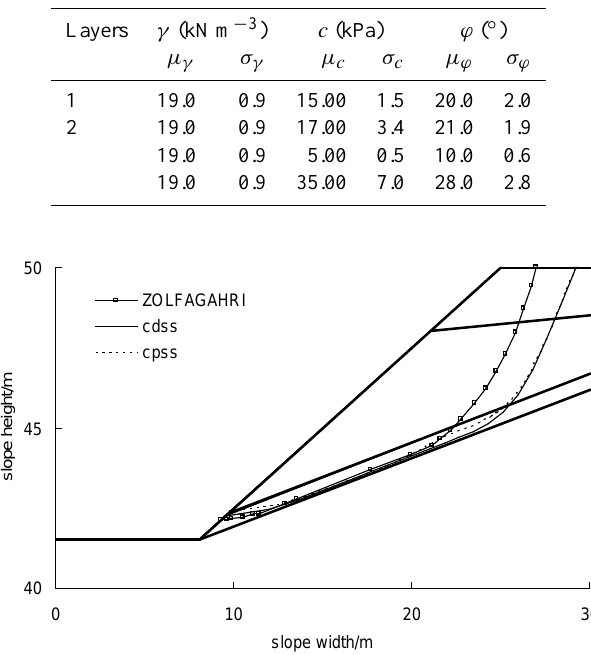
Table 9. Mean values and standard deviations for soil property pa- rameters (soil number from top to bottom).